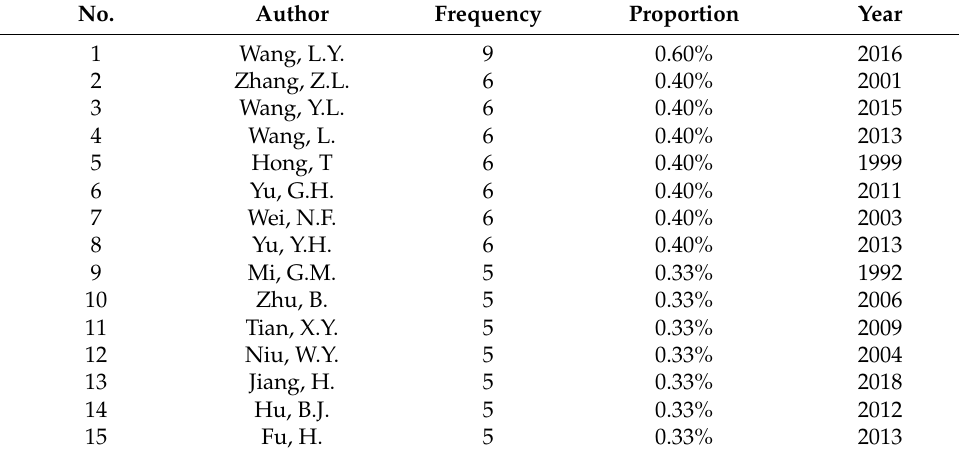
Table 2. The most productive authors in the field of HC in